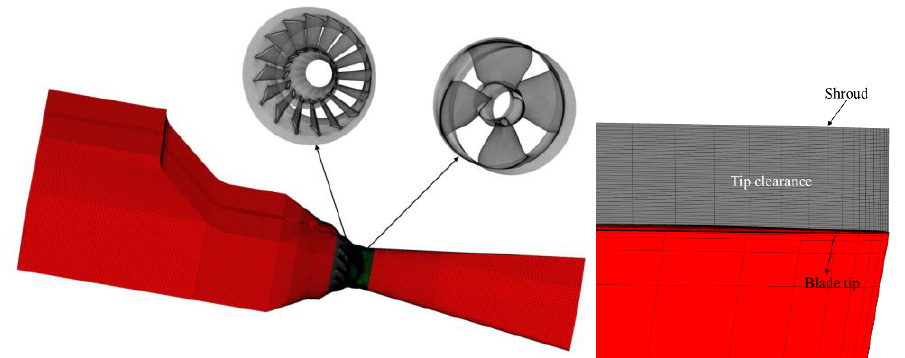
Figure 3. Computational domain grid.